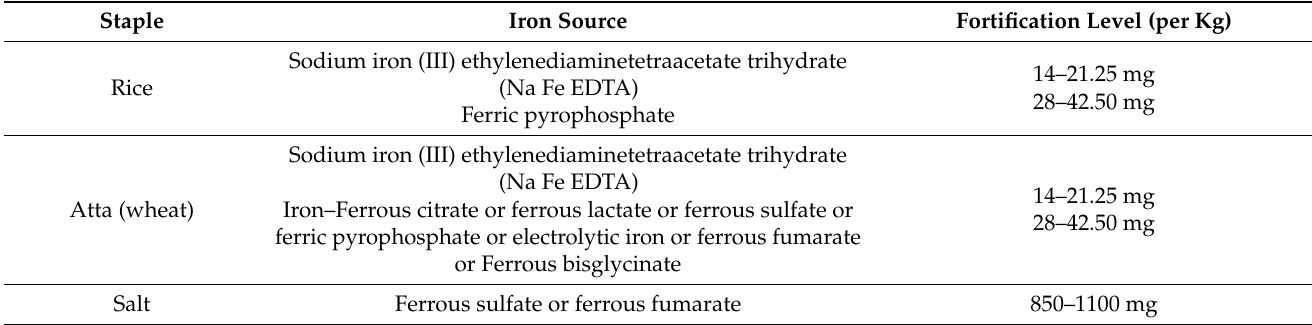
Table 2. Iron fortification standards recommendations by the Food Safety and Standards Authority of India.